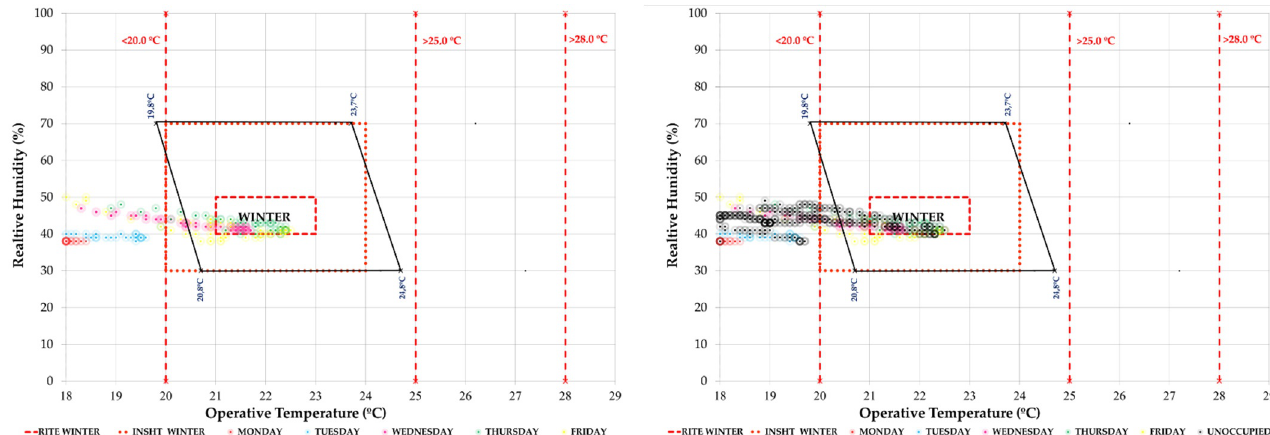
Figure 15. Indoor thermal comfort during the week of 11–15 January 2021 (Phase I) in the administra- tion office. Occupied hours are shown on the ( left ) and all hours, including unoccupied periods and the weekend, can be seen on the ( right ). Source: authors.